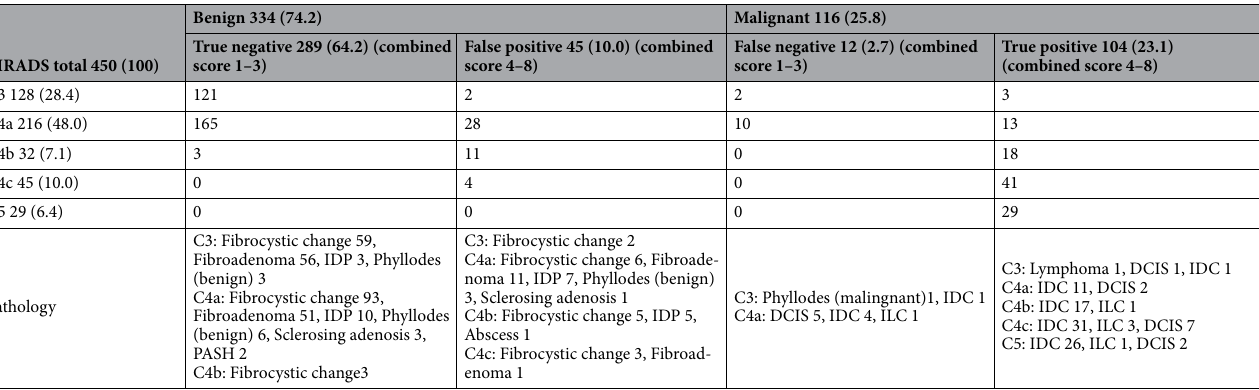
Table 3. Comparison of BI-RADS category and combined score between benign and malignant masses according to pathology. Values are presented as number (%). IDP: intraductal papilloma, PASH: pseudoangiomatous stromal hyperplasia, DCIS: ductal carcinoma in situ, IDC: infiltrative ductal carcinoma, ILC: infiltrative lobular carcinoma. BI-RADS category 3: C3, category 4a:C4a, category 4b: C4b, category